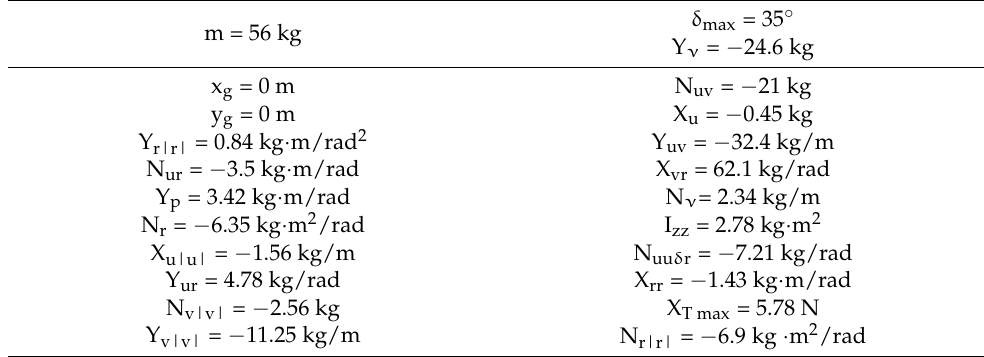
Table 3. Parameters of